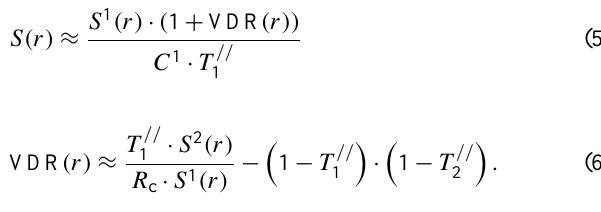
Fig. 2. Vertical profiles of the apparent backscatter coefficient Figure 2: Vertical profiles of the apparent backscatter coefficient )//(  ⊥ ) β //( app and VDR for the AL (top) and GBL (bottom). The molec- AL (top) and GBL (bottom). The molecular contribution is also indicated for the co-polar 577 ular contribution is also indicated for the co-polar and cross-polar and cross-polar channels. 578